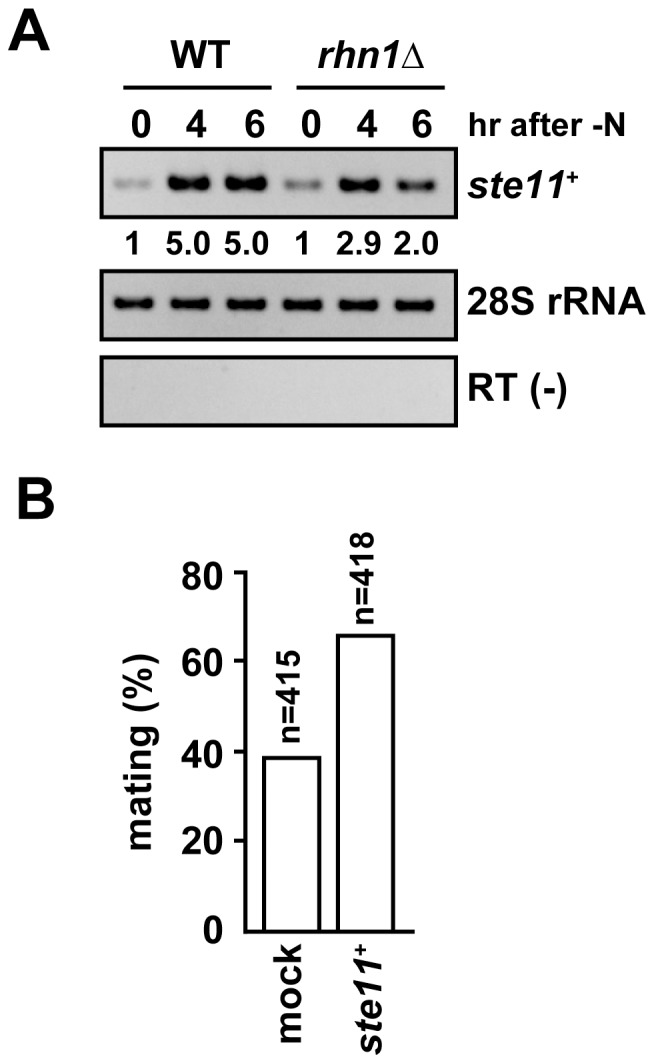
Rhn1 is essential for proper Ste11 expression.(A) ste11
+ induction after nitrogen starvation was delayed in rhn1Δ cells. Wild-type and rhn1Δ cells were grown to the mid-log phase in YEA at 30°C, washed with PMG-N, and then cultured in PMG-N at 26°C. RNA samples were collected at the indicated time points. The fold increases relative to wild-type cells are shown below each lane. (B) Expression of exogenous ste11
+ rescued the mating inefficiency of rhn1Δ cells. The rhn1Δ cells that harbored either pREP1 (mock) or pREP1-ste11
+ (ste11
+) vector were examined for mating after incubation on PMG-leu plates at 26°C for 3 days. “n” indicates the number of cells counted.